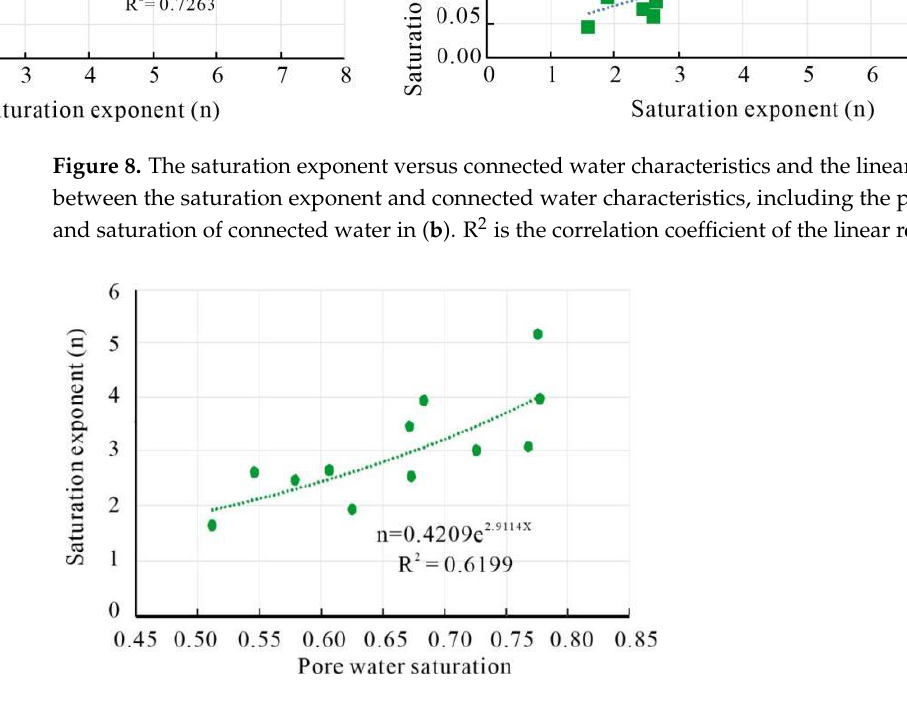
Figure 9. The saturation exponent versus pore water saturation. Tortuosity is a geometric parameter related to electrical properties [16]. Zhang et al.